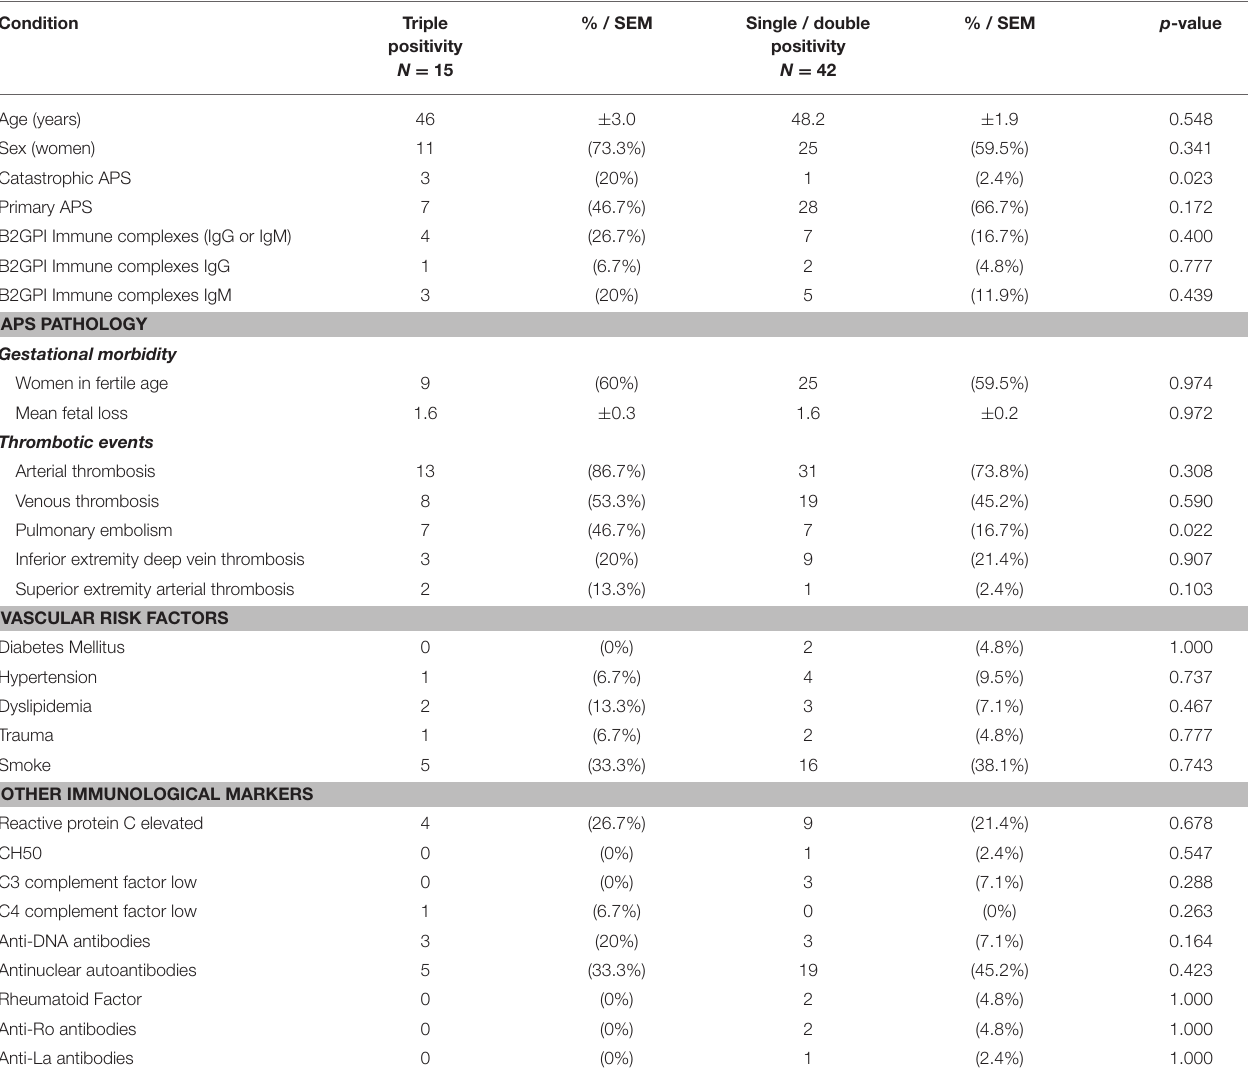
TABLE 3 | Clinical characteristics of APS patients with triple aPL positivity vs. single or double aPL positivity.